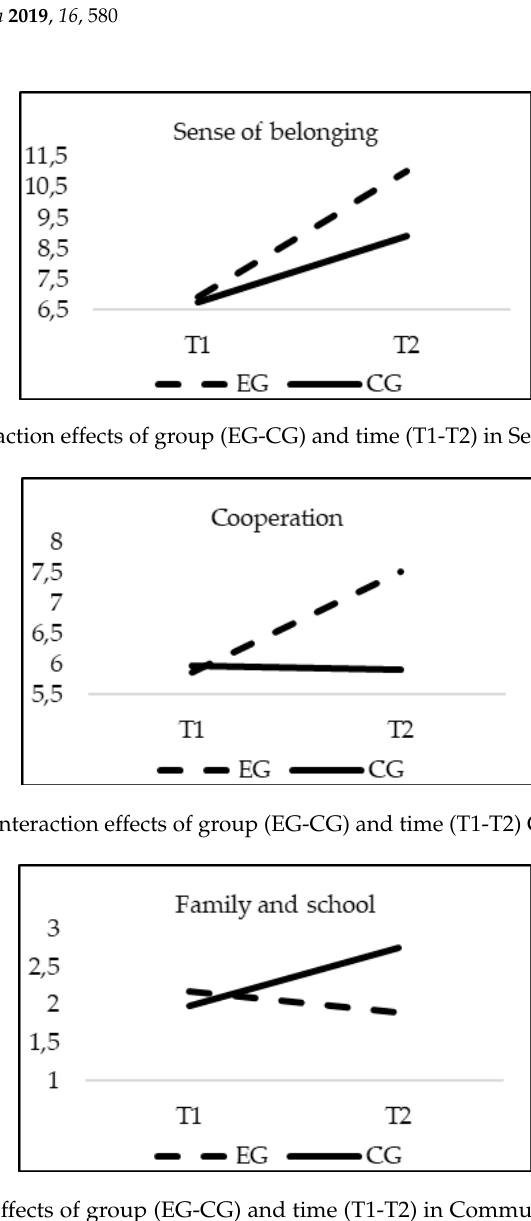
and and school. and school.